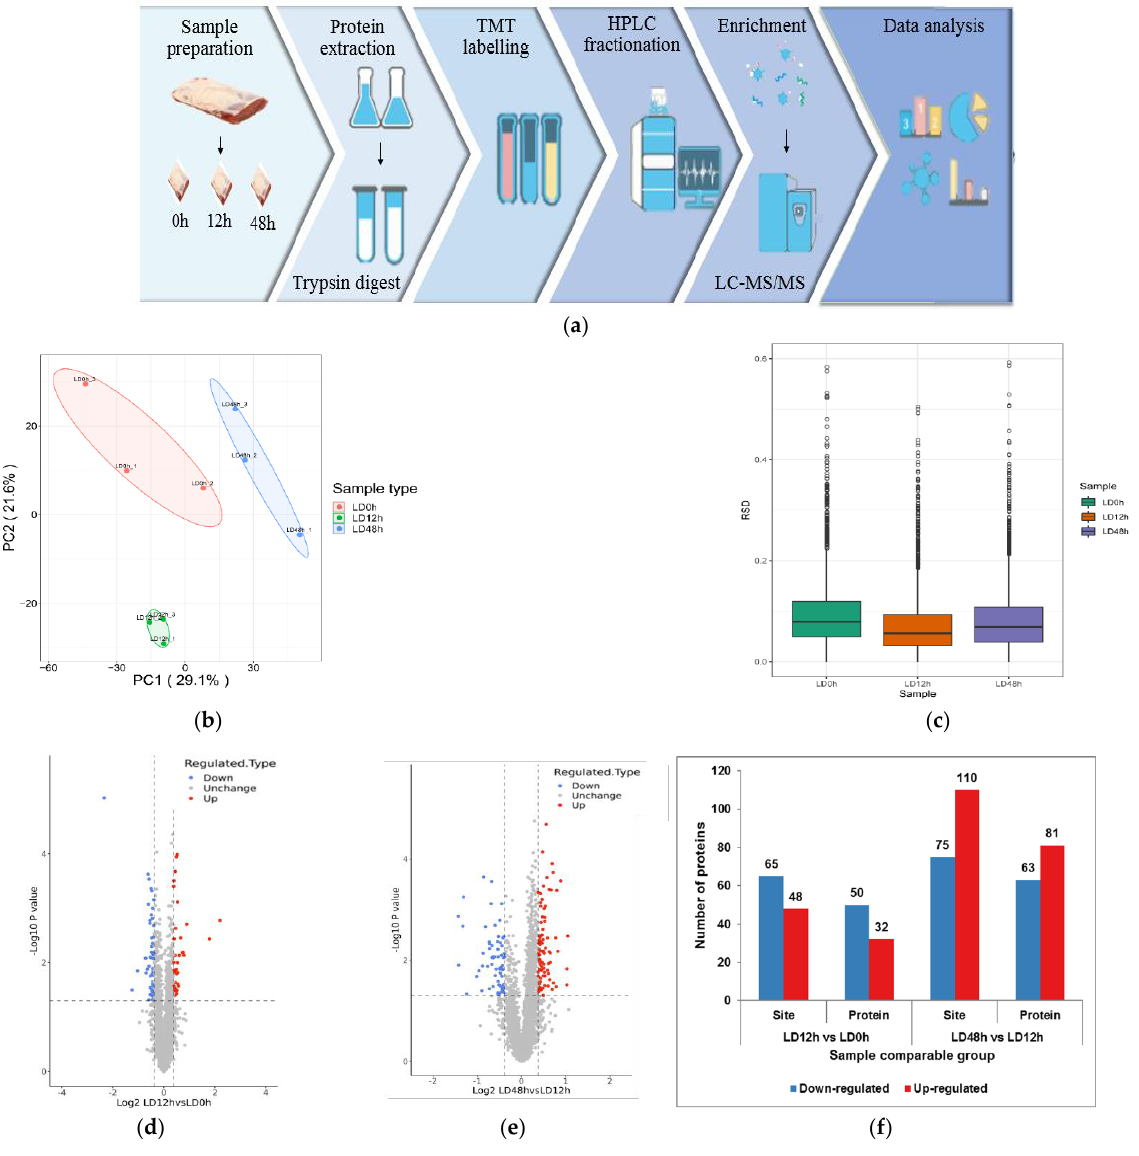
Figure 2. Identification of differentially expressed proteins in postmortem pork muscle. ( a ) The schematic overview for the quantitative analysis of pork muscle proteome and phosphoproteome at 0 h to 48 h postmortem. ( b ) Two-dimensional scatter plot of PCA distribution of protein quantitation. ( c ) RSD of protein quantitation. ( d ) Volcano plot of the differentially expressed proteins between 0 h and 12 h postmortem. ( e ) Volcano plot of the differentially expressed proteins between 12 h and 48 h postmortem. ( f ) Quantitative analysis of differentially expressed proteins in different sample comparable groups.